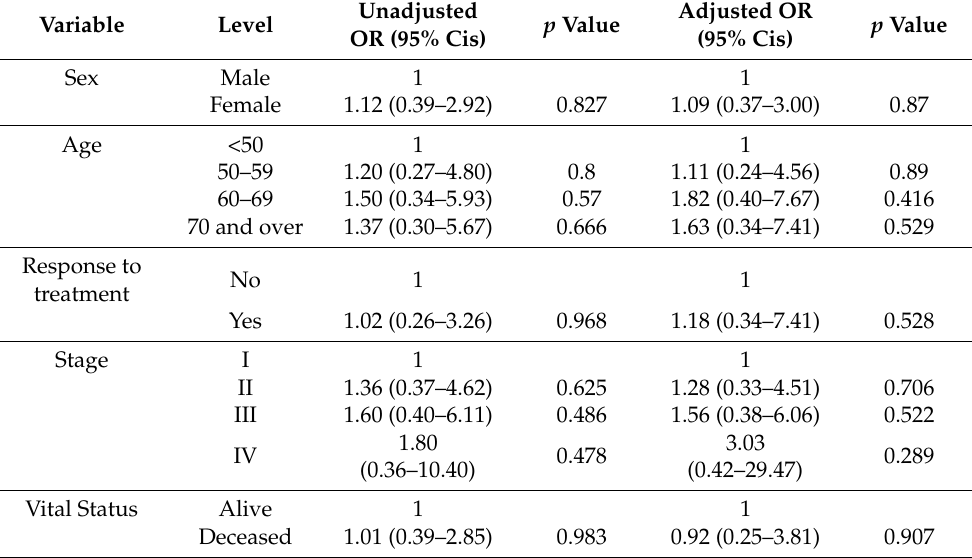
Table 3. Influence of A1 sub-lineage presence stratified by demographic and clinical variables. The comparator for the odds ratio (univariate and adjusted) is A1